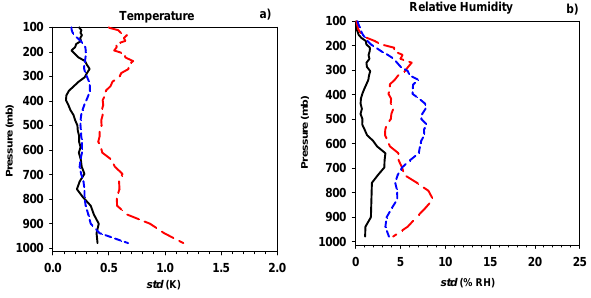
Fig. 3. (a) Temperature retrievals and (b) Relative humidity re- trievals. Square roots of diagonal elements of the covariance matrices of the: retrieval noise (solid black lines); temporal non-coincidence of 0.5h (dashed blue lines); and spatial non- coincidence error of 20km (dashed red